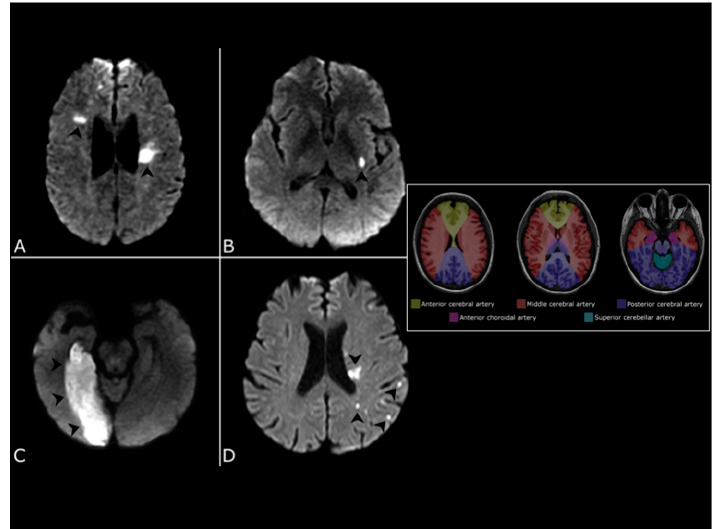
Figure 4. Neuroimaging features of embolic lesion. Diffusion-weighted MRI showing different lesion (arrowheads) patterns. ( A ) bilateral lesions in the right and left middle cerebral artery territory. ( B ) small subcortical lesion. ( C ) large corticosubcortical lesion in the right posterior cerebral artery territory. ( D ) multiple small lesions in the left middle cerebral artery territory. A cartoon showing cerebral vascular territories at the level of the body of the lateral ventricles (left image), at the level of the basal ganglia and internal capsule (center image) and at the level of the mesencephalon (right image) is provided.